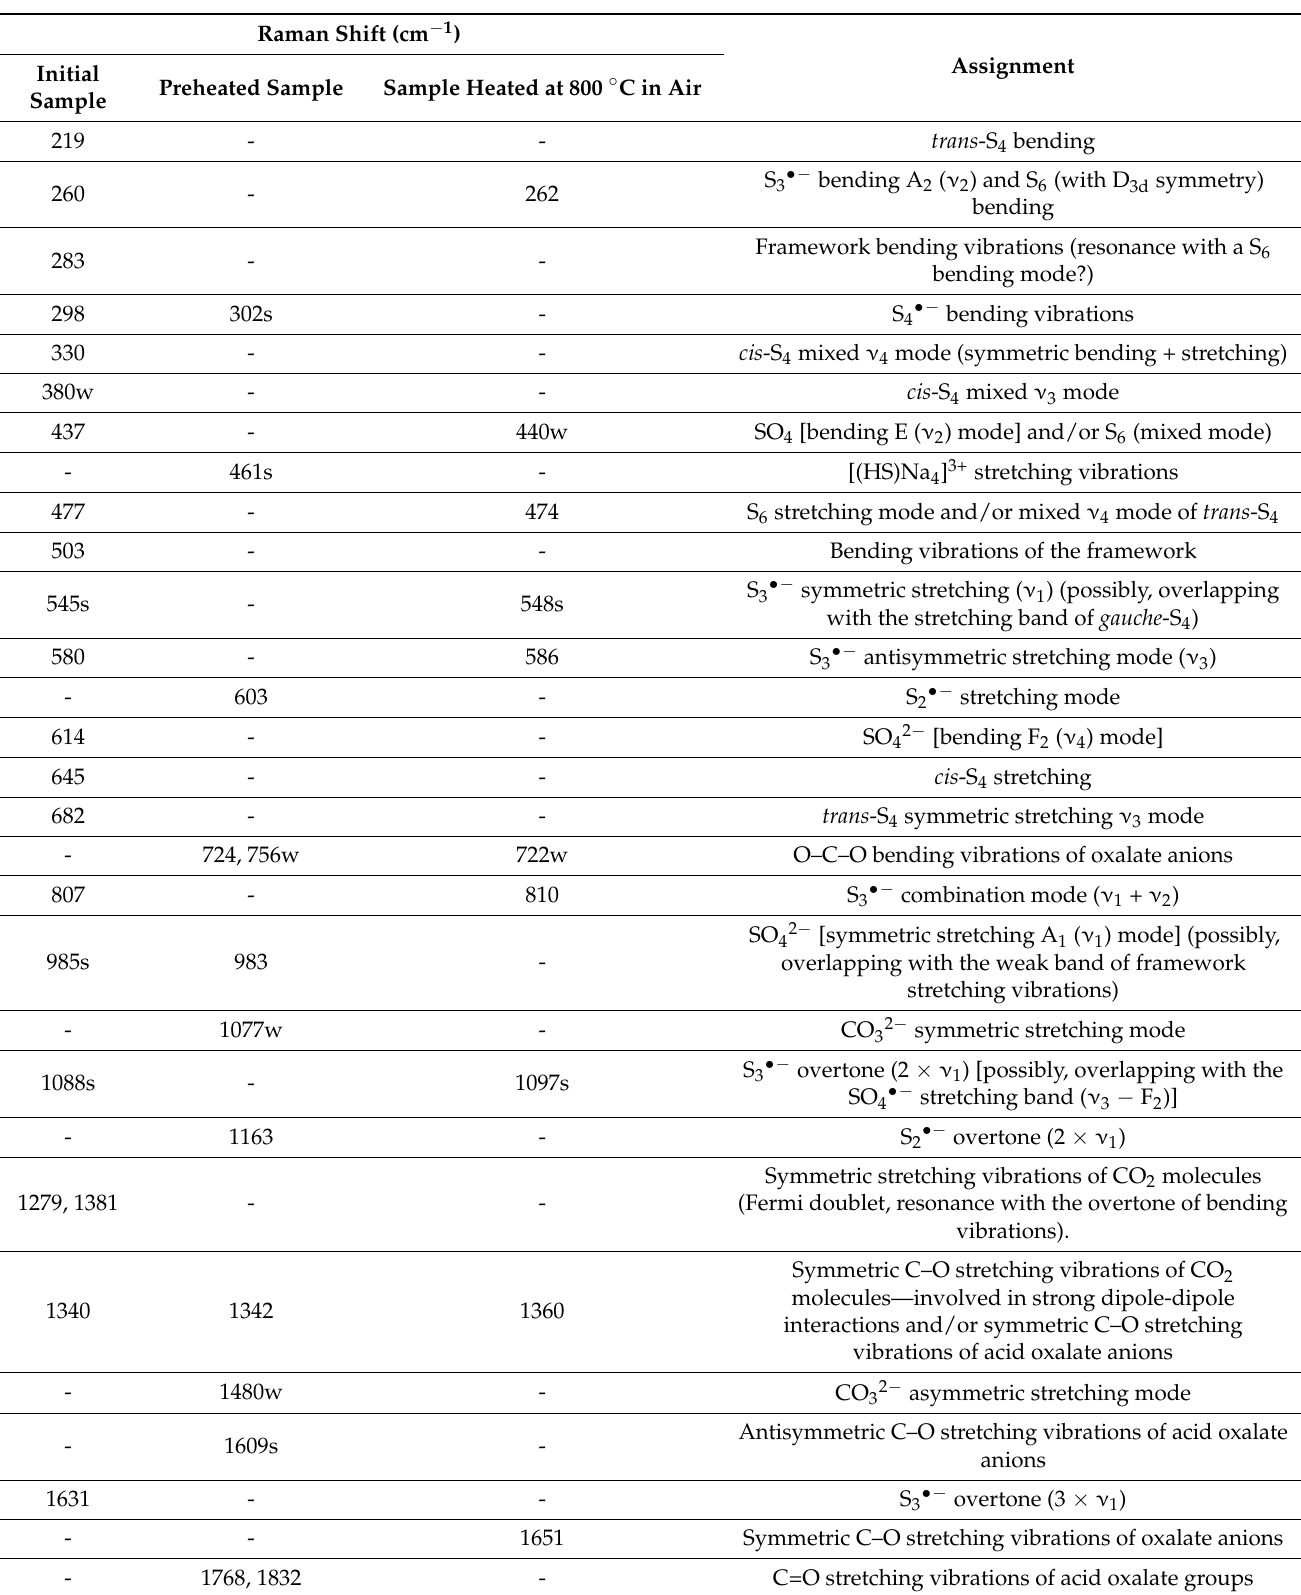
Table 5. Assignment of Raman bands of slyudyankaite and products of its thermal